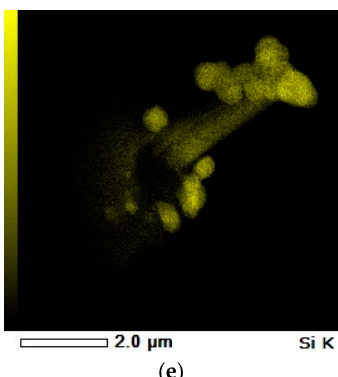
Figure 10. X-ray spectroscopy ( EDS) mapping of final product obtained in the experiment V3F, ( a ) BF-SEM Image, ( b ) C K-carbon mapping, ( c ) Mg K-magnesium mapping, ( d ) O K-oxygen mapping, and ( e ) Si K-silicon mapping.